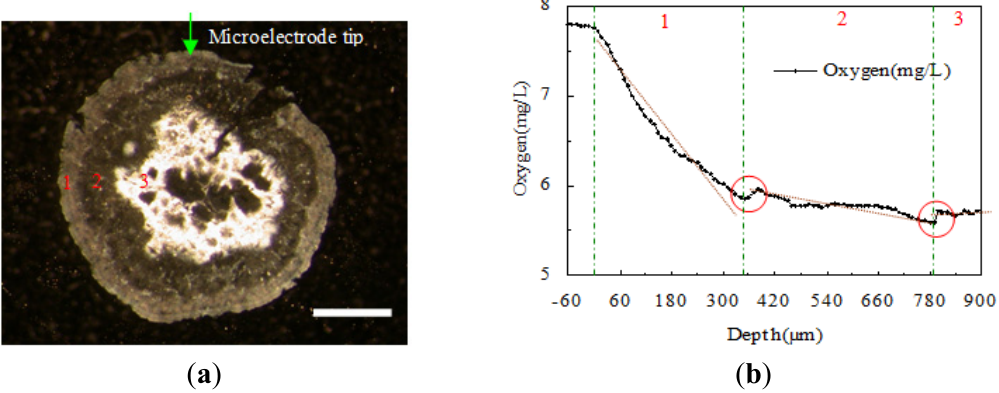
Figure 4. Granule section image by freezing microtome and DO profile by microelectrode system. ( a ) Image of a granule cross section (scale bar = 1 mm); ( b ) Profile of DO transfer variation in a granule in tap